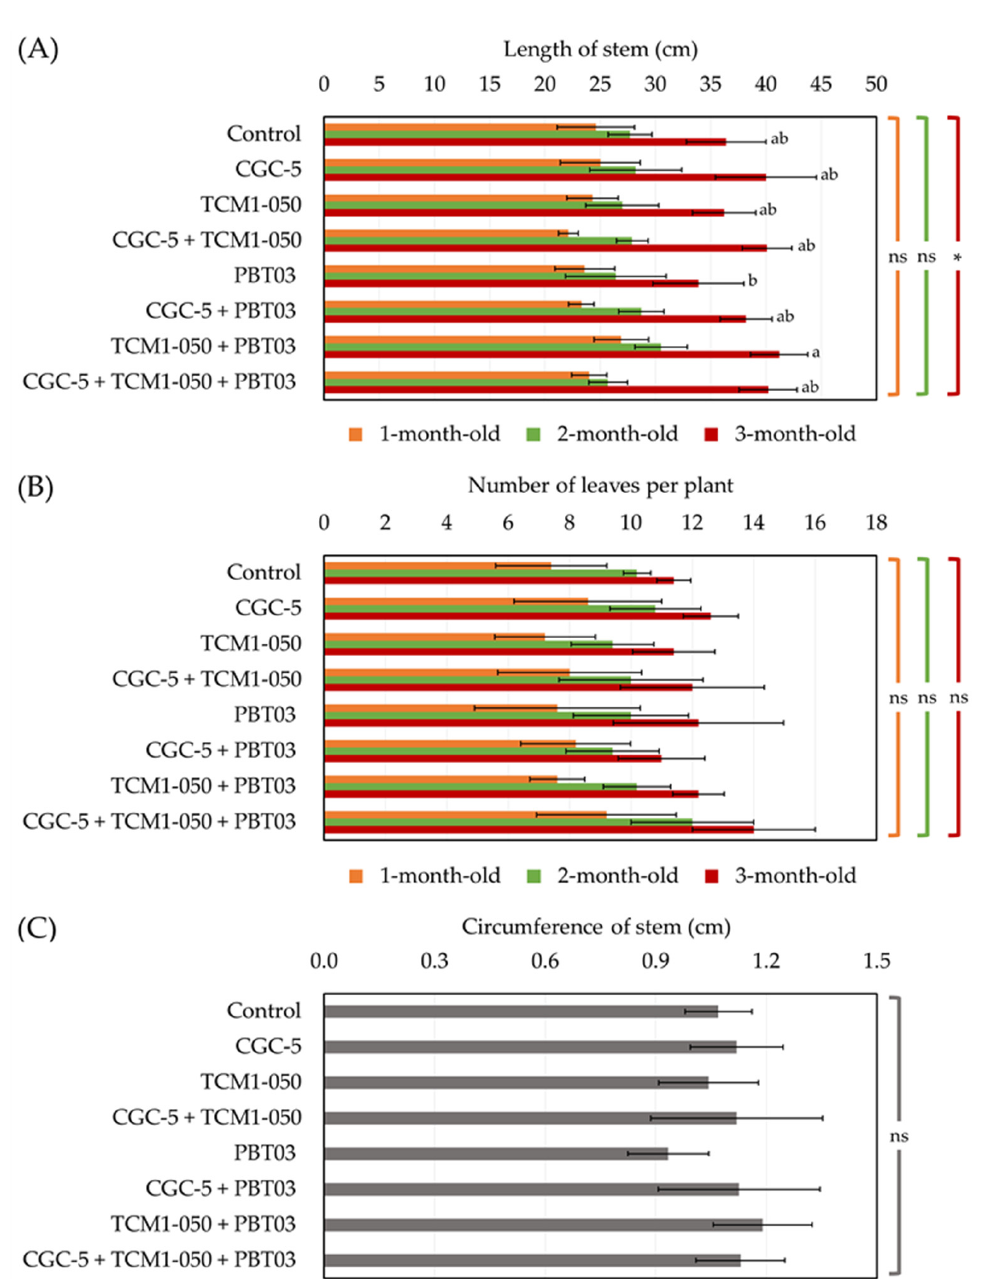
Figure 3. Impacts of teak rhizosphere microbes on stem length ( A ), leaf number per plant ( B ), and stem circumference of teak seedlings. Different treatments were established, including an uninoculated control and those inoculated with Agrobacterium sp. CGC-5, Kitasatospora sp. TCM1-050, Claroideoglomus sp. PBT03, or different consortia of these microbes. The experiments were done in five replicates. Small case letters refer to the statistical difference of means compared by one-way ANOVA at α = 0.05. The statistical results comprise of ( A ) length of stem at 1-months-old ( F (7, 32) = 1.60, p = 0.17), 2-months-old ( F (7, 32) = 1.29, p = 0.29), and 3-months-old ( F (7, 32) = 3.13, p ≤ 0.0005), ( B ) number of leave per plant at 1-months-old ( F (7, 32) = 0.53, p = 0.80), 2-months-old ( F (7, 32) = 1.36, p = 0.25), and 3-months-old ( F (7, 32) = 1.52, p = 0.195), and ( C ) circumference of stem ( F (7, 32) = 1.25, p = 0.31). The asterisk remark indicates the statistical significance, while “ns” refers to “no